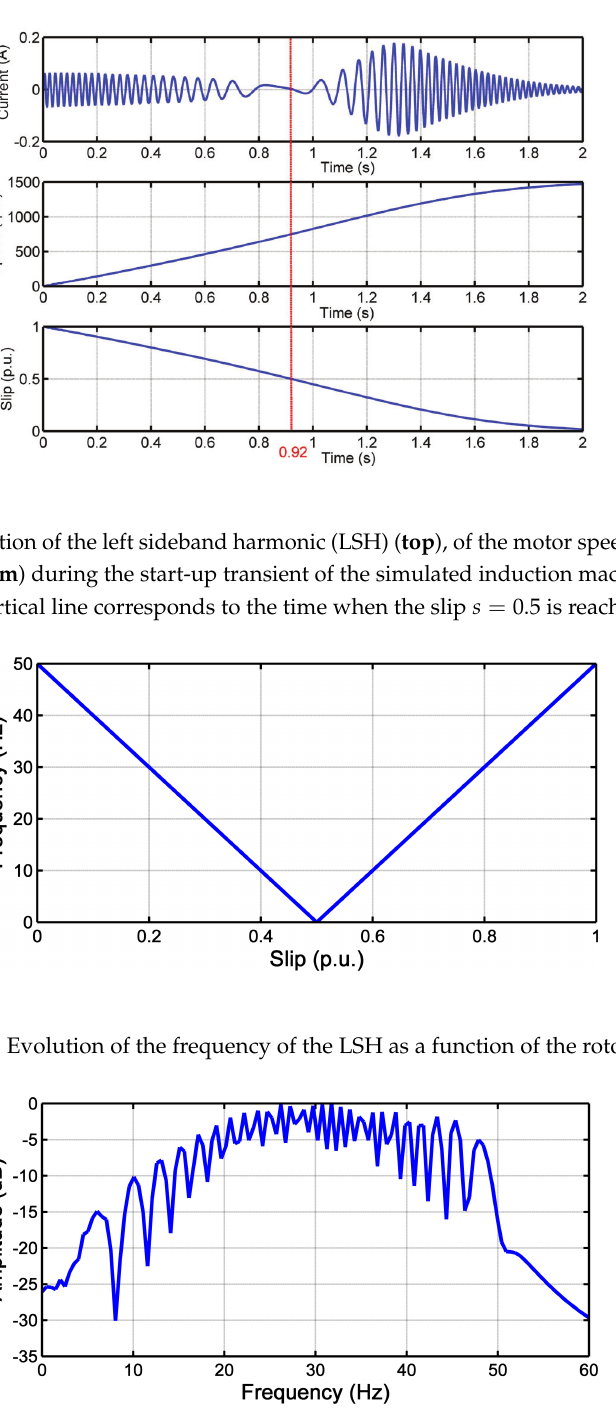
Figure 5. Spectrum of the